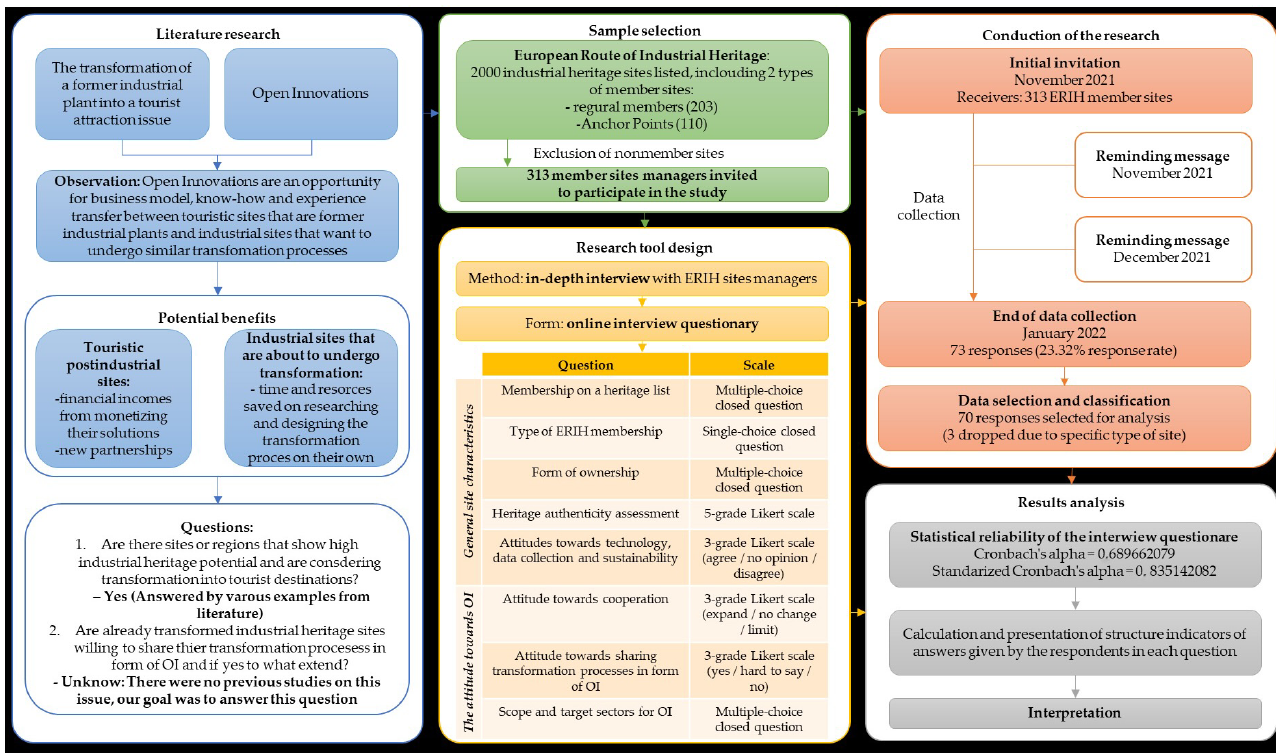
Figure 1. Diagram of the research